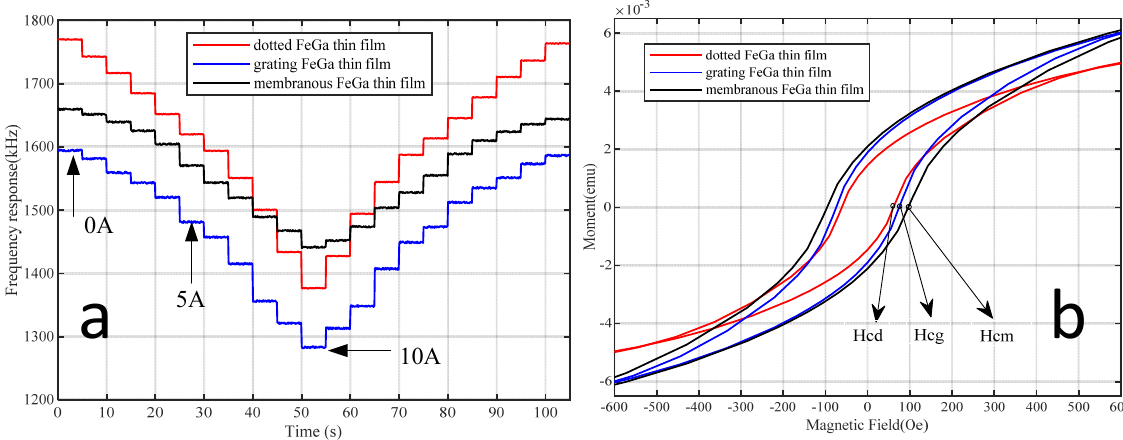
Figure 9. ( a ) The hysteresis of the proposed sensors; and ( b ) the hysteresis loop of patterned FeGa thin film. Table 1 concludes the sensing performance of the proposed sensors with various FeGa film patterns. Obviously, the dot-patterned FeGa film coated sensing device features larger sensitivity and lower hysteresis error. Table 2 offers the sensing performance